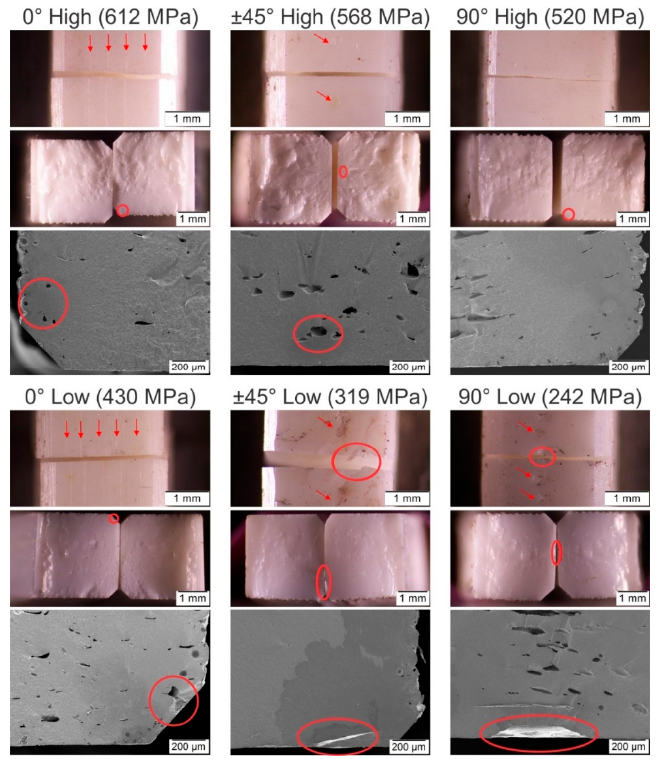
Figure 10. Tensile surfaces and fracture surfaces of specimens with high and low strength and Influence of the defects on the first layer produced during shaping by FFF for the specimens with high and low strength produced with infill orientations of 0°, ±45° and 90°. Arrows mark periodic defects between the roads produced during FFF. Locations of the fracture origins are marked with circles and the defects in the tensile surface are marked with arrows.